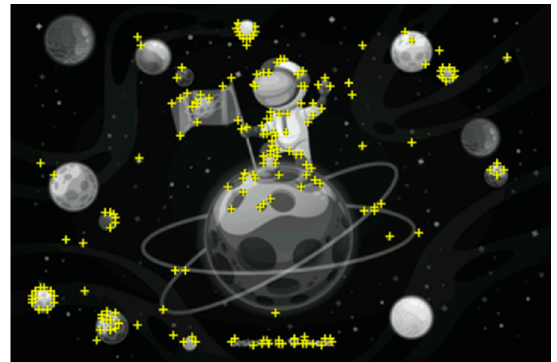
Figure 13. Image target evaluated on the Vuforia website.